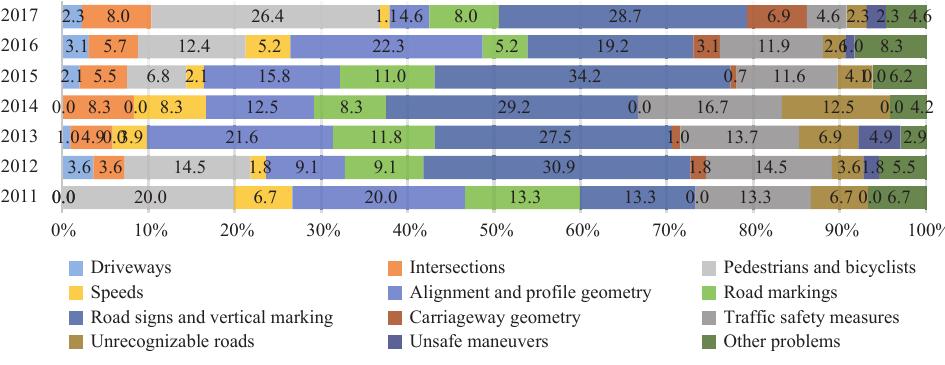
Figure 7. The occurrence frequency of each problem category for regional roads